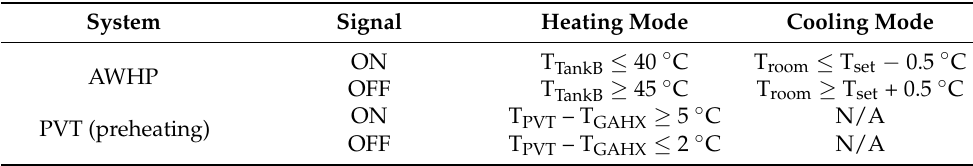
Table 2. Control strategies for hybrid trigeneration